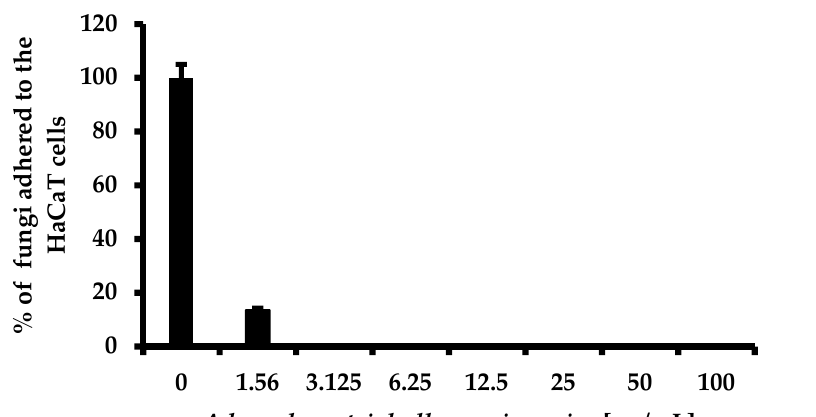
Figure 5. A. triphylla var. japonica extract inhibited the adherence of C. albicans to HaCaT cells. C. albicans (1 × 10 6 cells/mL) containing the indicated concentration of A. triphylla var. japonica extract was incubated for 24 h at 37 °C and the remaining Candida cells on HaCaT cells were counted. Experiments were performed in triplicate.